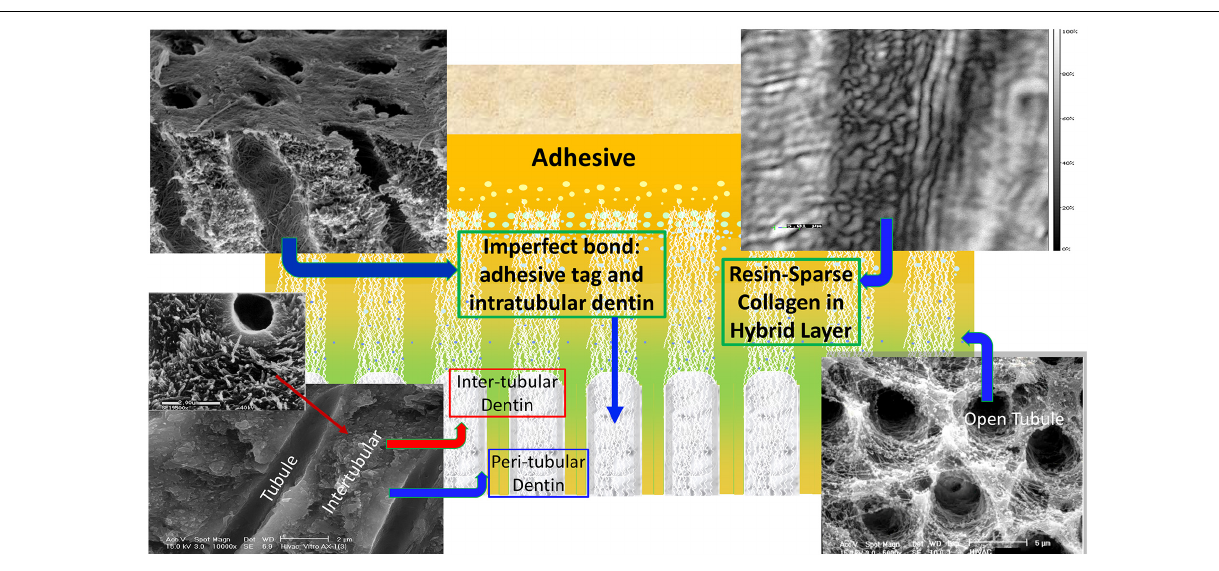
FIGURE 2 | A schematic depicting cross-section of adhesive infiltrating dentin. Areas of resin-sparse collagen within the hybrid layer are illustrated as well as imperfect adhesive bonds to intra-, inter-, and peritubular